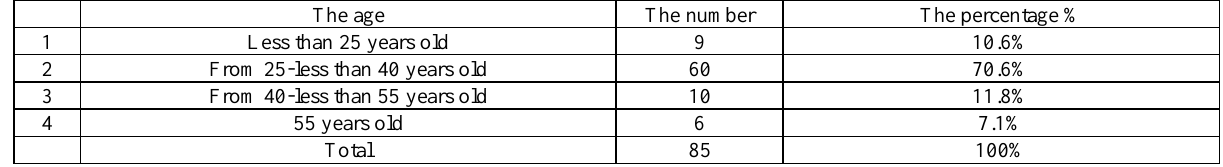
Table 3. Distribution of members of the study sample according to age